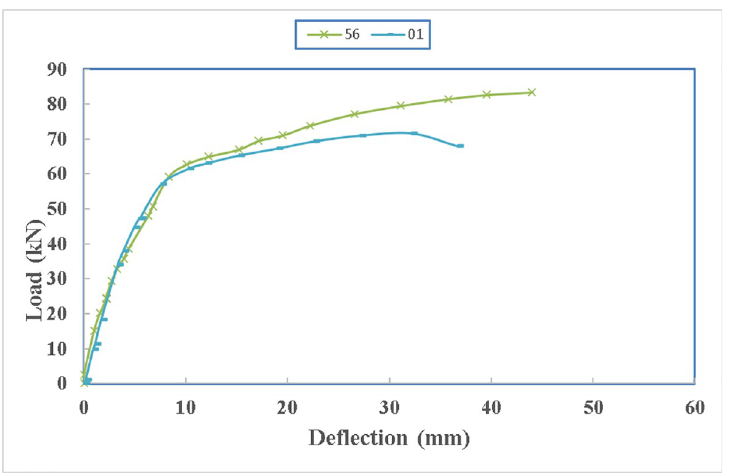
Fig 25. Load- deflection diagram between beam 56 and beam